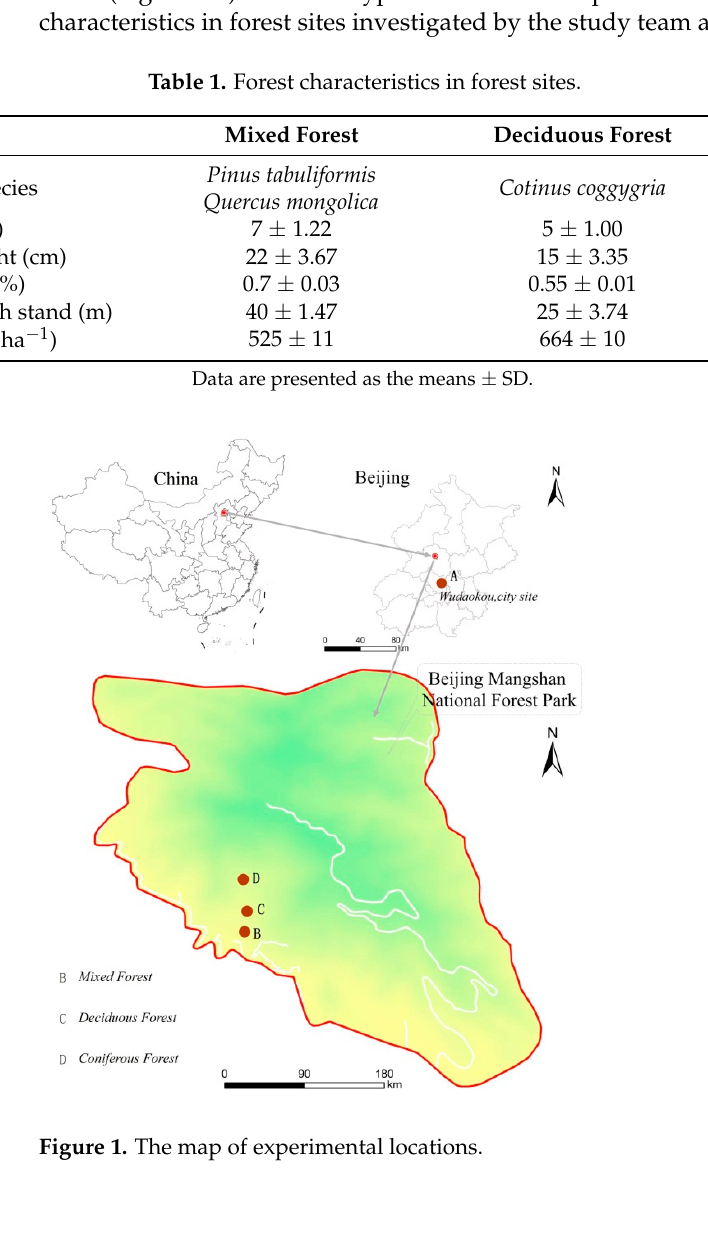
Figure 2. Photos: ( A ) city site, ( B ) mixed forest, ( C ) deciduous forest, ( D ) coniferous forest. 2.3. Procedures The experiment took place in June 2021 in sunny weather conditions. Participants were exposed to each of the study sites at the same time of a different day. The study protocol was the same for each experiment (Figure 3). Participants gathered in a class-